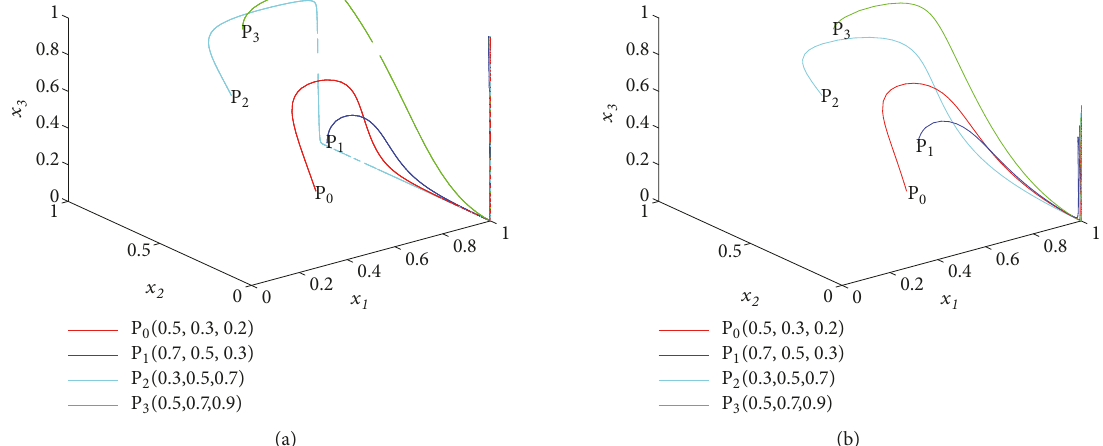
Figure 10: Phase diagrams of dynamical system of tripartite game under combined mechanisms of incentive reward and flexible